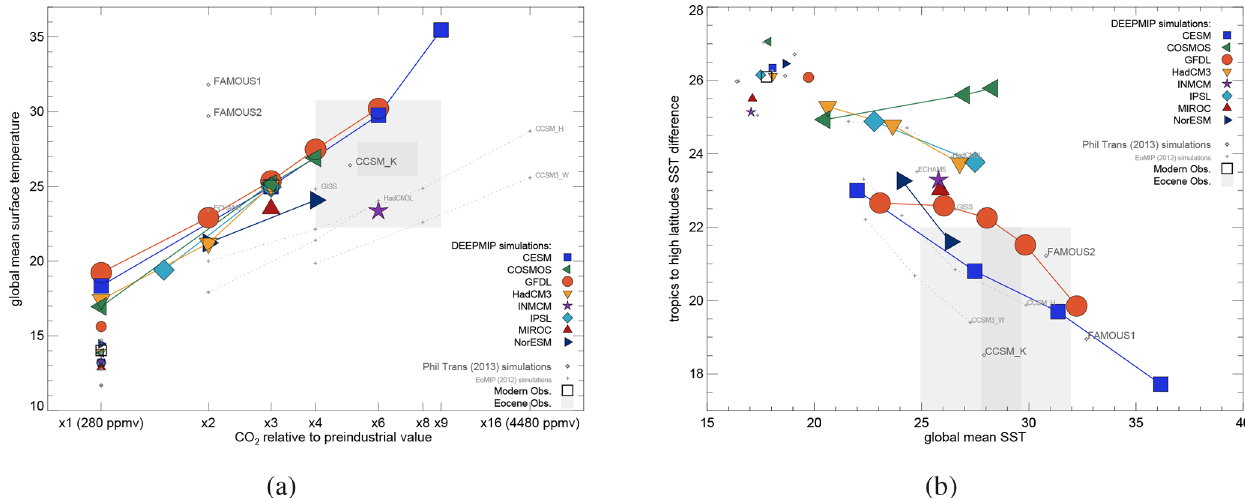
Figure 1. (a) Global annual mean near-surface (2m) air temperature in the DeepMIP simulations, as a function of atmospheric CO 2 . Large coloured symbols show the Eocene simulations, and smaller coloured symbols show the associated preindustrial controls. Also shown are results from some previous Eocene simulations (Lunt et al., 2012; Kiehl and Shields, 2013; Sagoo et al., 2013) and associated preindustrial control simulations (small grey symbols). The models that have carried out Eocene simulations at more than one CO 2 concentration are joined by a straight line. The open square shows modern observations. The grey filled boxes show estimates of the global mean temperature (from Inglis et al., 2020) and CO 2 (from Anagnostou et al., 2020) derived from proxies. For temperature, the light grey box shows the 10% to 90% confidence interval and the dark grey box shows the 33% to 66% confidence interval; for CO 2 , the light grey box shows ± 1 SD and the dark grey box shows ± 2 SD; see Sect. 3.4 for more details. Panel (b) is the same as panel (a) but for the meridional SST gradient as a function of global mean SST. The meridional SST gradient is defined here as the average SST equatorwards of ± 30 ◦ minus the average SST polewards of ± 60 ◦ . The grey filled boxes show estimates of the global mean SST (from Inglis et al., 2020) and SST gradient (from Cramwinckel et al., 2018; Evans et al., 2018; Zhu et al., 2019) derived from proxies. For SST, the light grey box shows the 10% to 90% confidence interval and the dark grey box shows the 33% to 66% confidence interval; for the meridional temperature gradient, the light grey box shows the range (which extends below the y axis limit, down to 14 ◦ C); see Sect. 3.4 for more